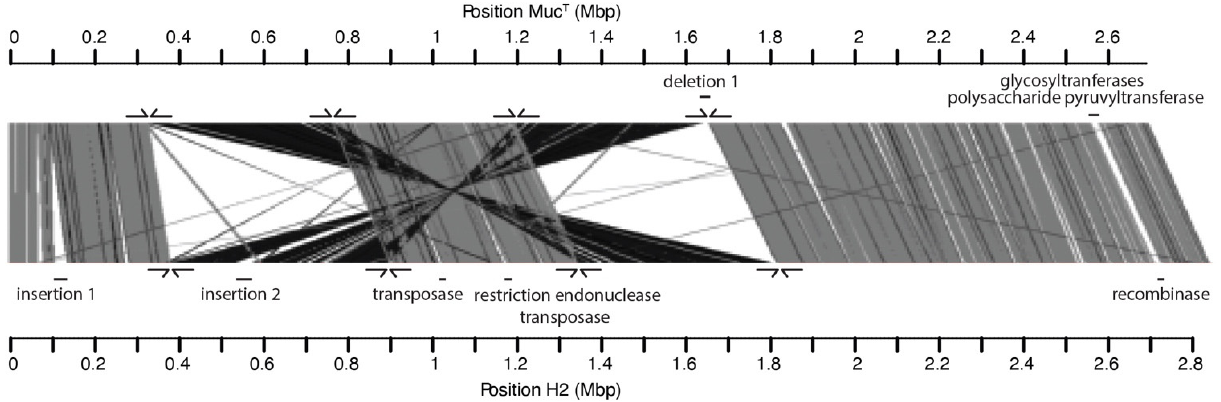
Figure 2. Comparison of the complete genomes of Muc T and H2. Alignment of the genomes of Muc T and H2 in ACT [58] and visualized in a linear way using the WebACT comparison tool [59]. (-) indicates non-homologous sequences. Arrows indicate primer-binding sites.